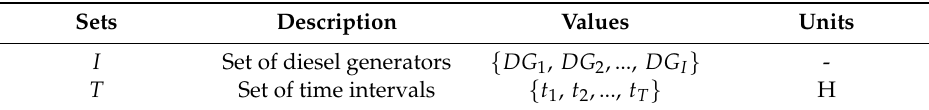
Table 6. List of sets in the MIP model.